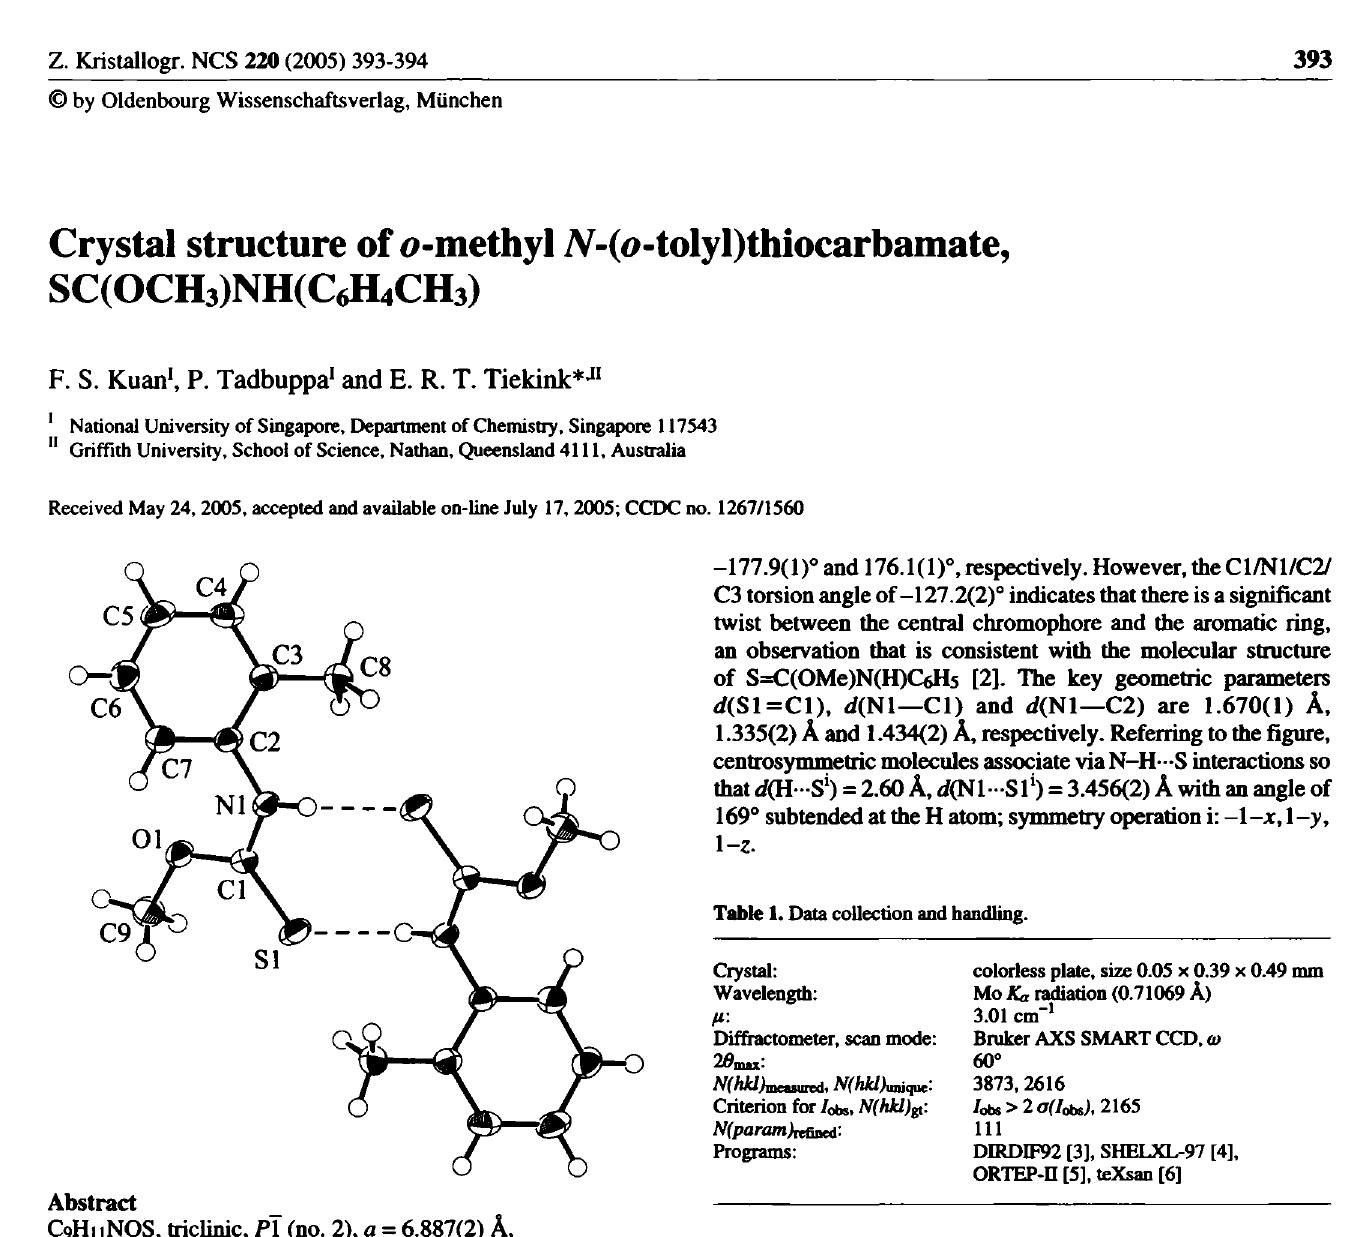
Table 2. Atomic coordinates and displacement parameters (in A 2